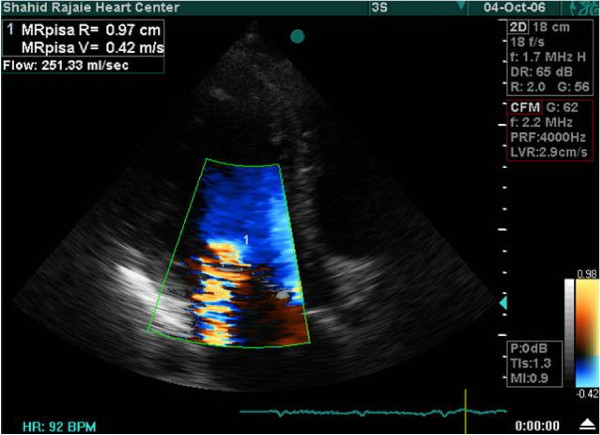
Echocardiographic assessment of MR severity by PISA. Measurement of PISA radius, ERO and regurgitant volume for assessment of MR severity using color Doppler imaging and CW Doppler.